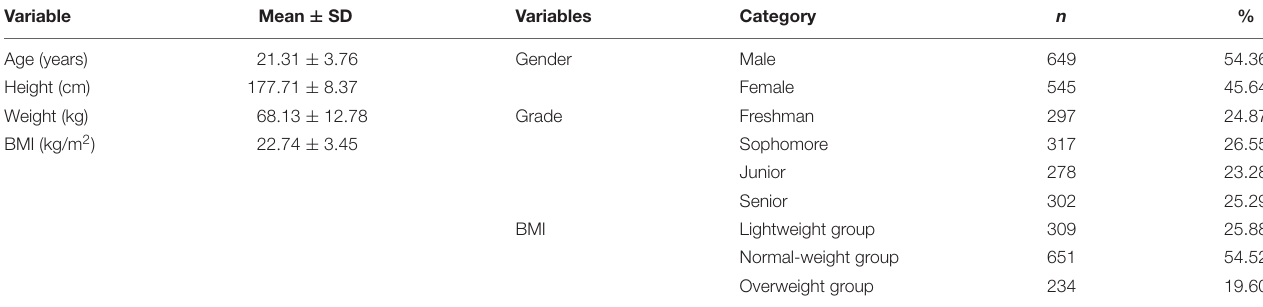
TABLE 1 | Basic information of the sample ( N =